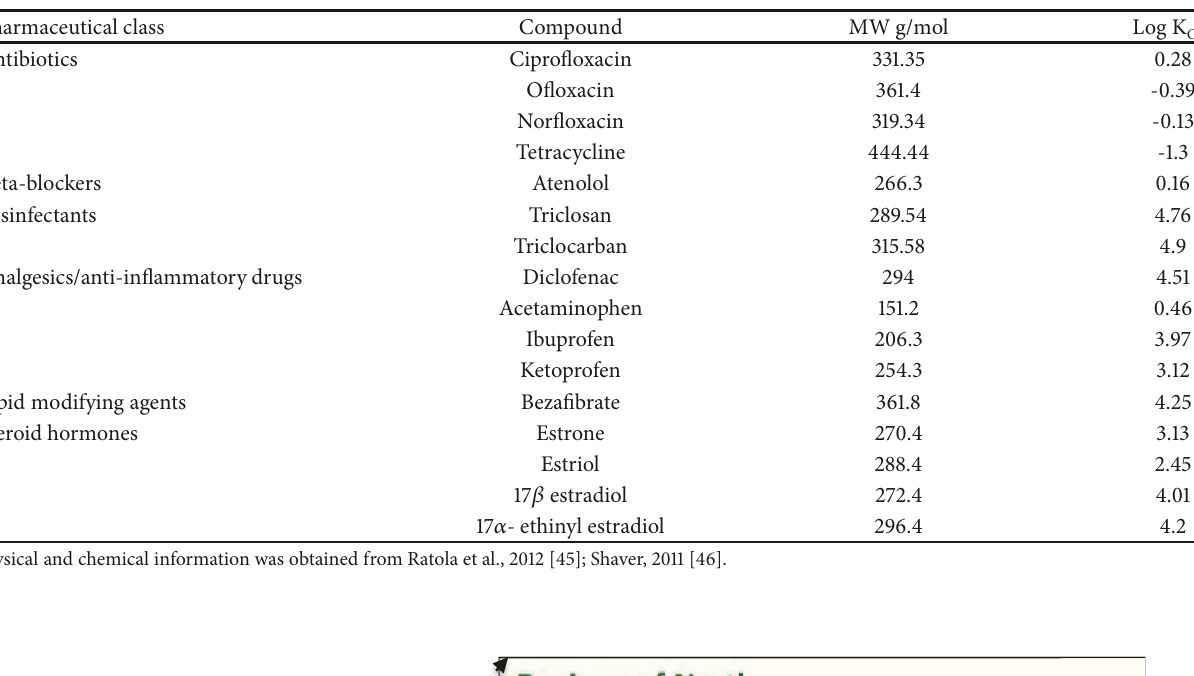
Table 2: Selected pharmaceuticals and their physicochemical properties.